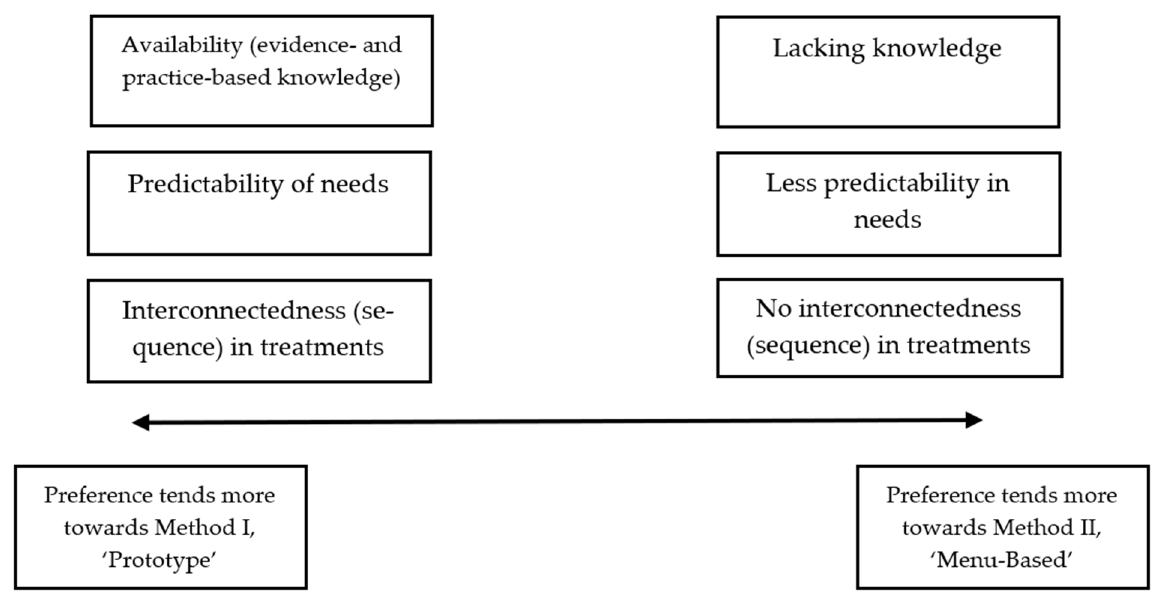
Figure 2. Subdivision in preference Method I ‘Prototype’ or Method II ‘Menu-based’ outlined as a conductive scale.